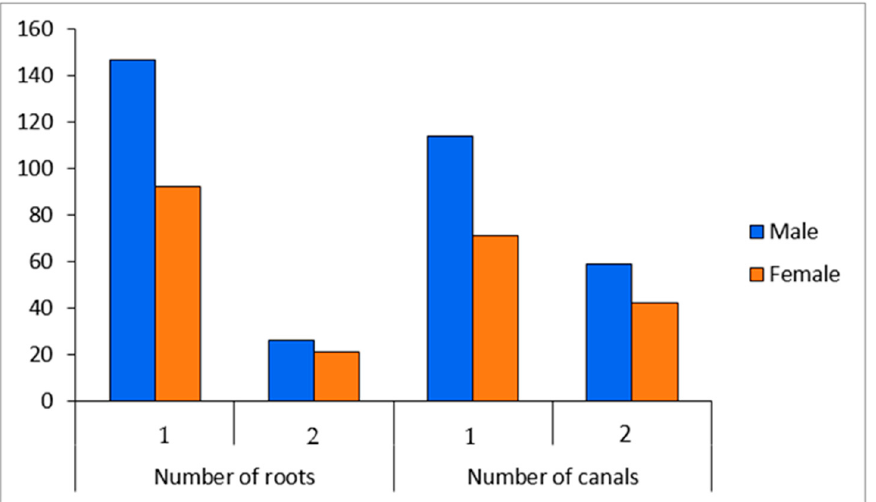
Figure 3. Number of roots and canals in relation to gender.